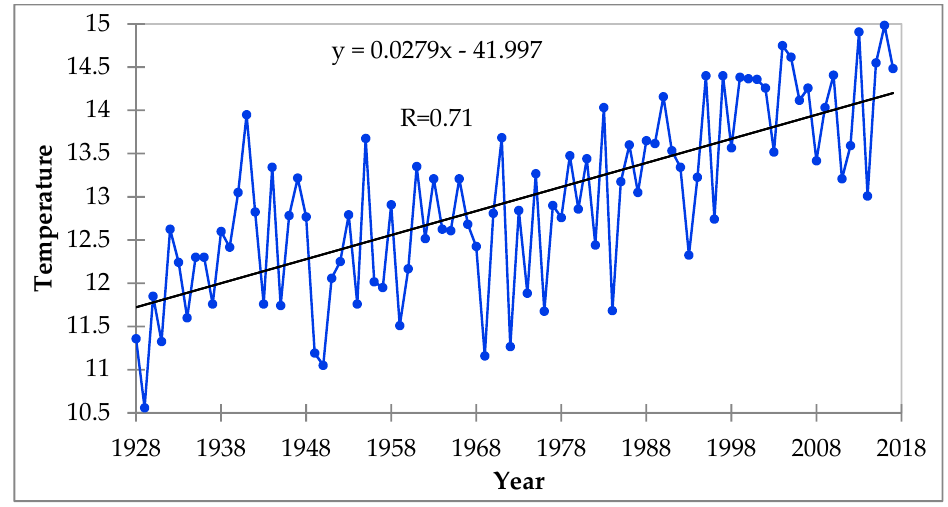
Figure 2. Average annual temperature at the Khiva weather station from 1928 to 2017.